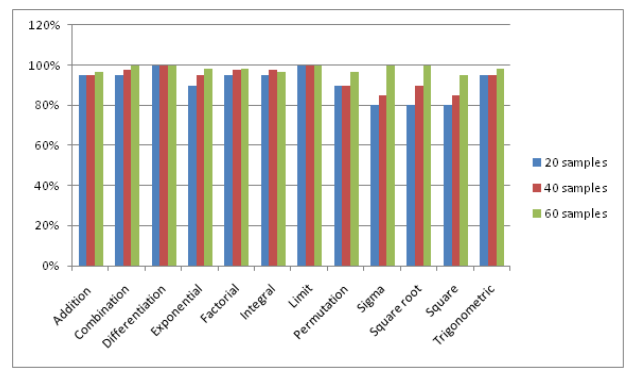
Figure 4. Efficiency Measure with Tensorflow from the